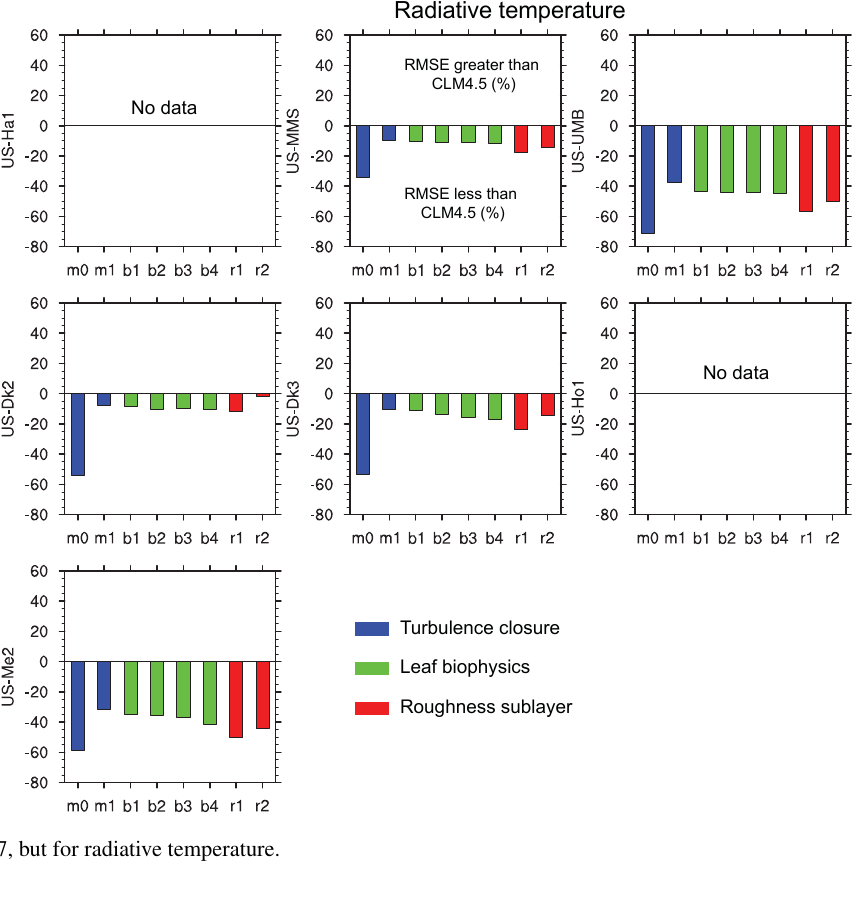
Figure 10. As in Fig. 7, but for radiative temperature.